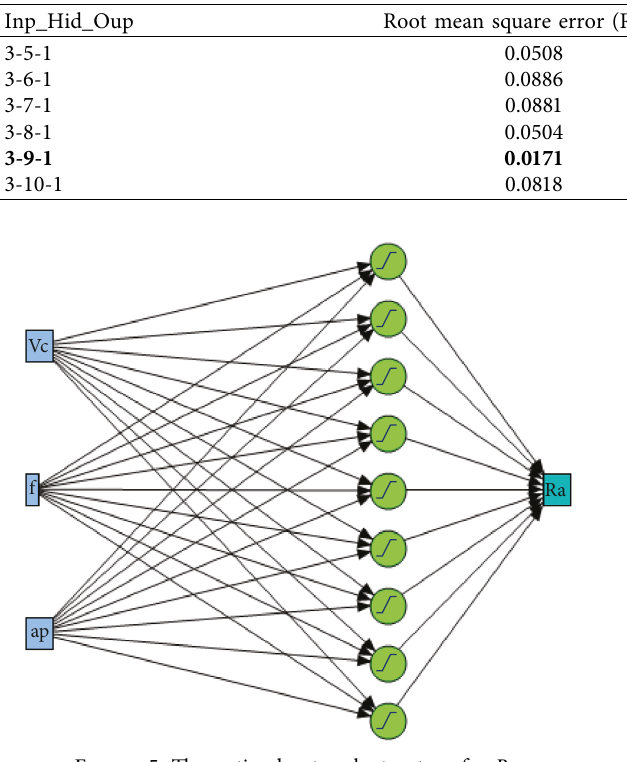
Figure 5: The optimal network structure for Ra